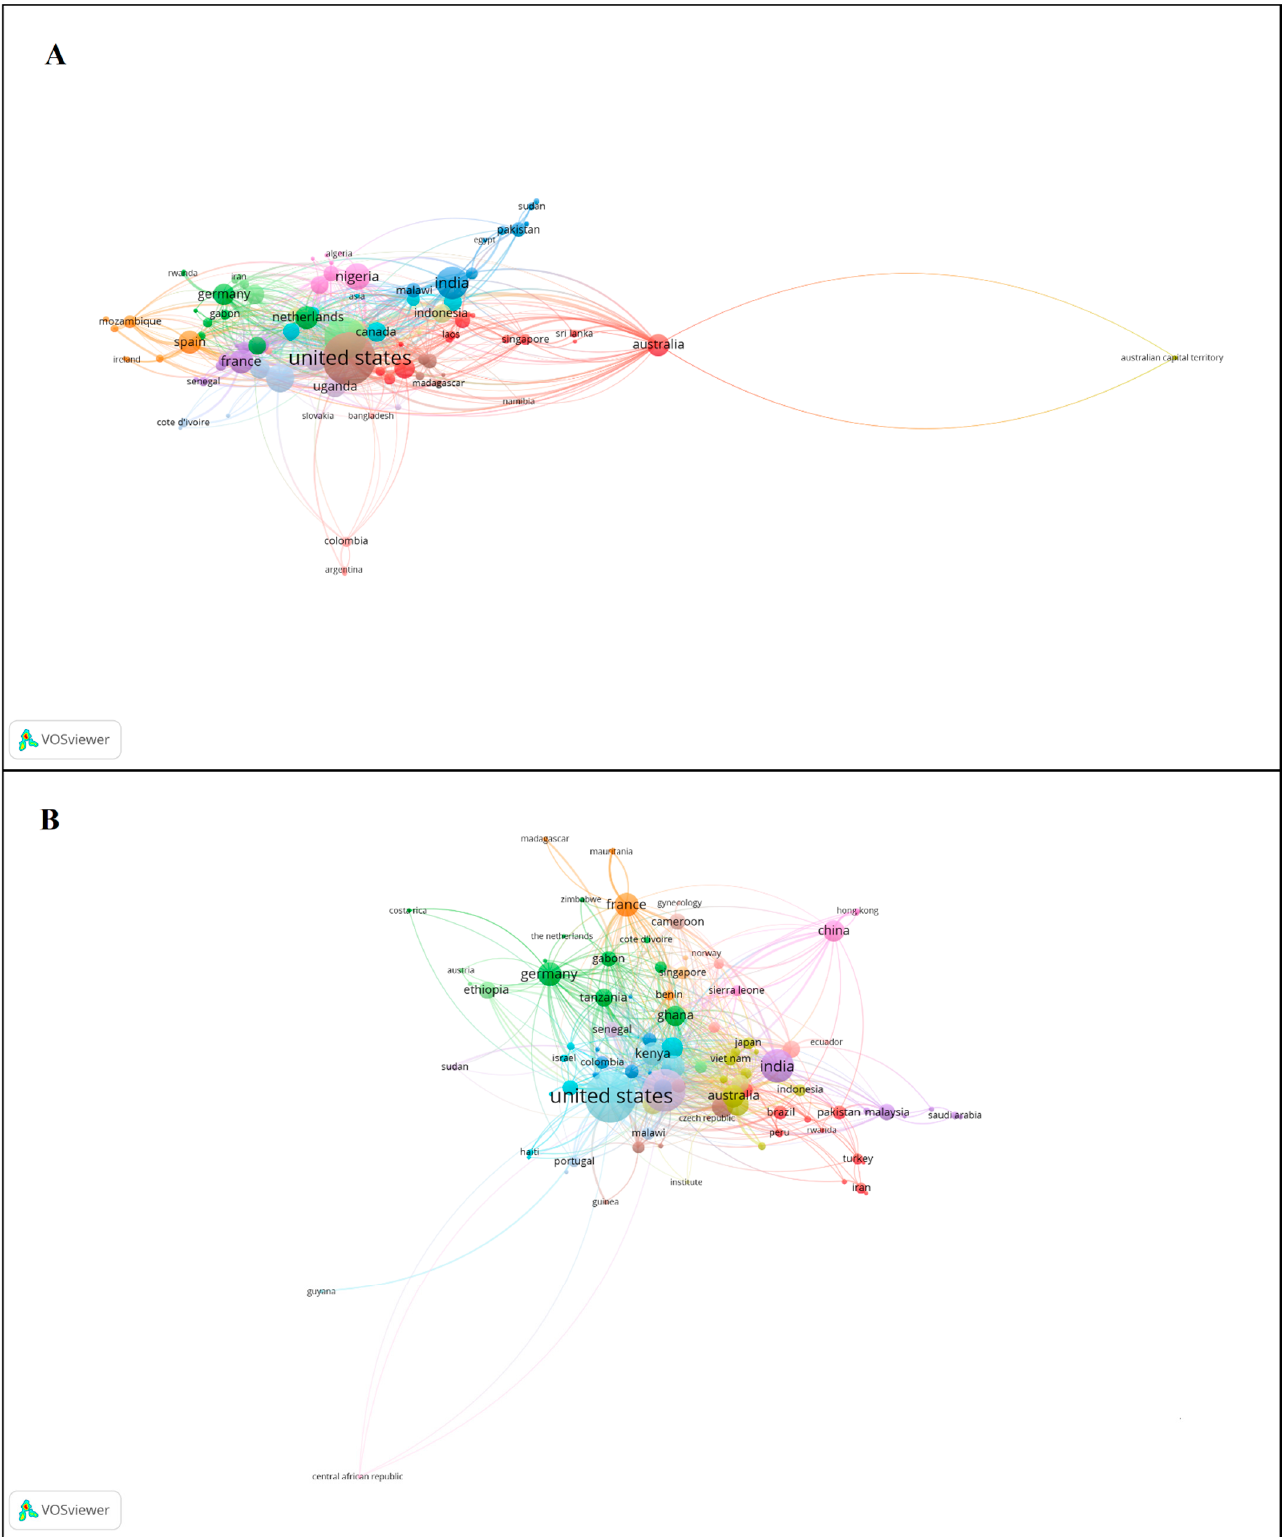
Figure 3. Countries that contributed significantly to malaria publications ( A ) before the COVID-19 pandemic, ( B ) during the COVID-19 pandemic.